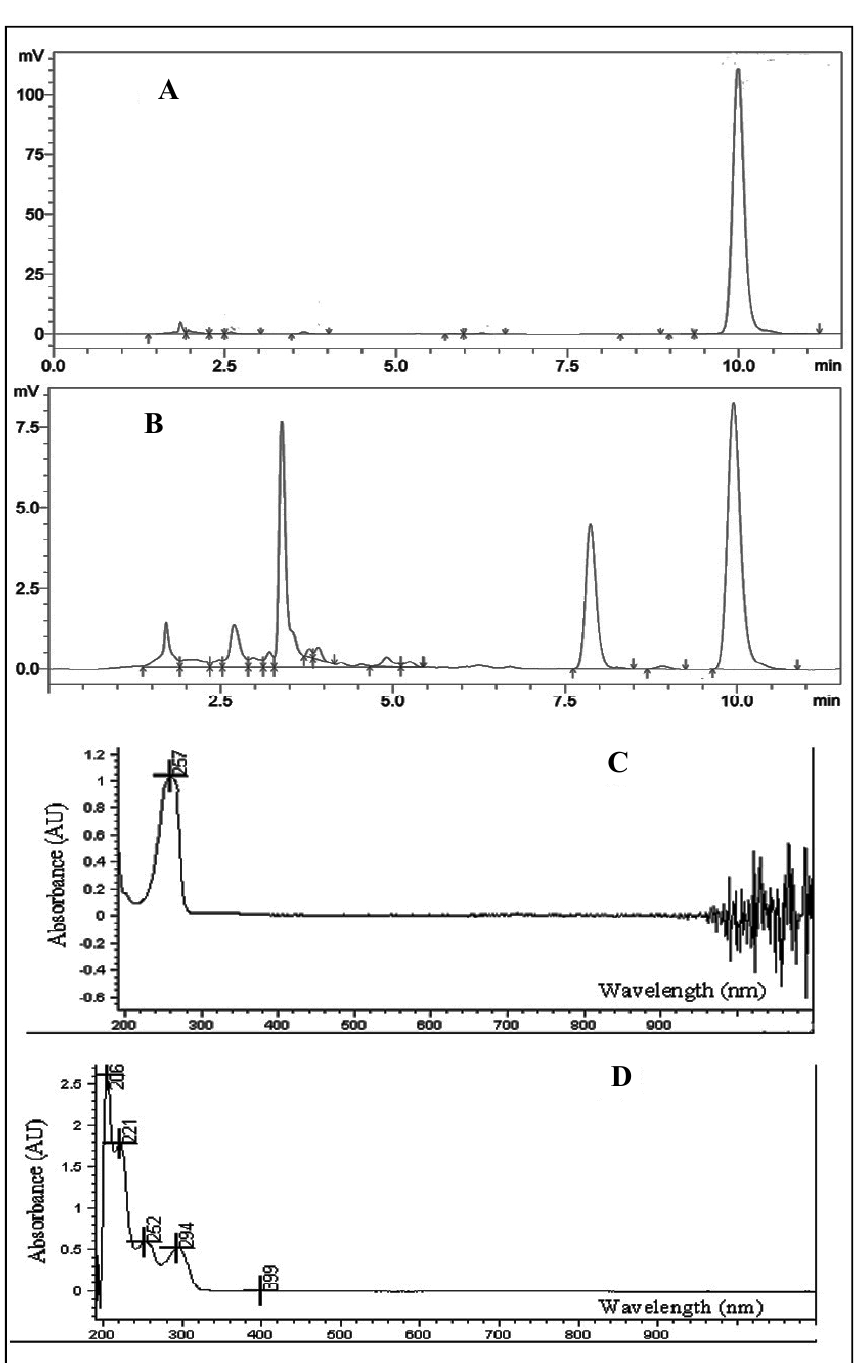
Figure 7. Initial HPLC chromatographs of TQ ( A ), after 48 h light stability study ( B ) and the initial UV-VIS spectrum of TQ ( C ), after 48 h light stability study ( D